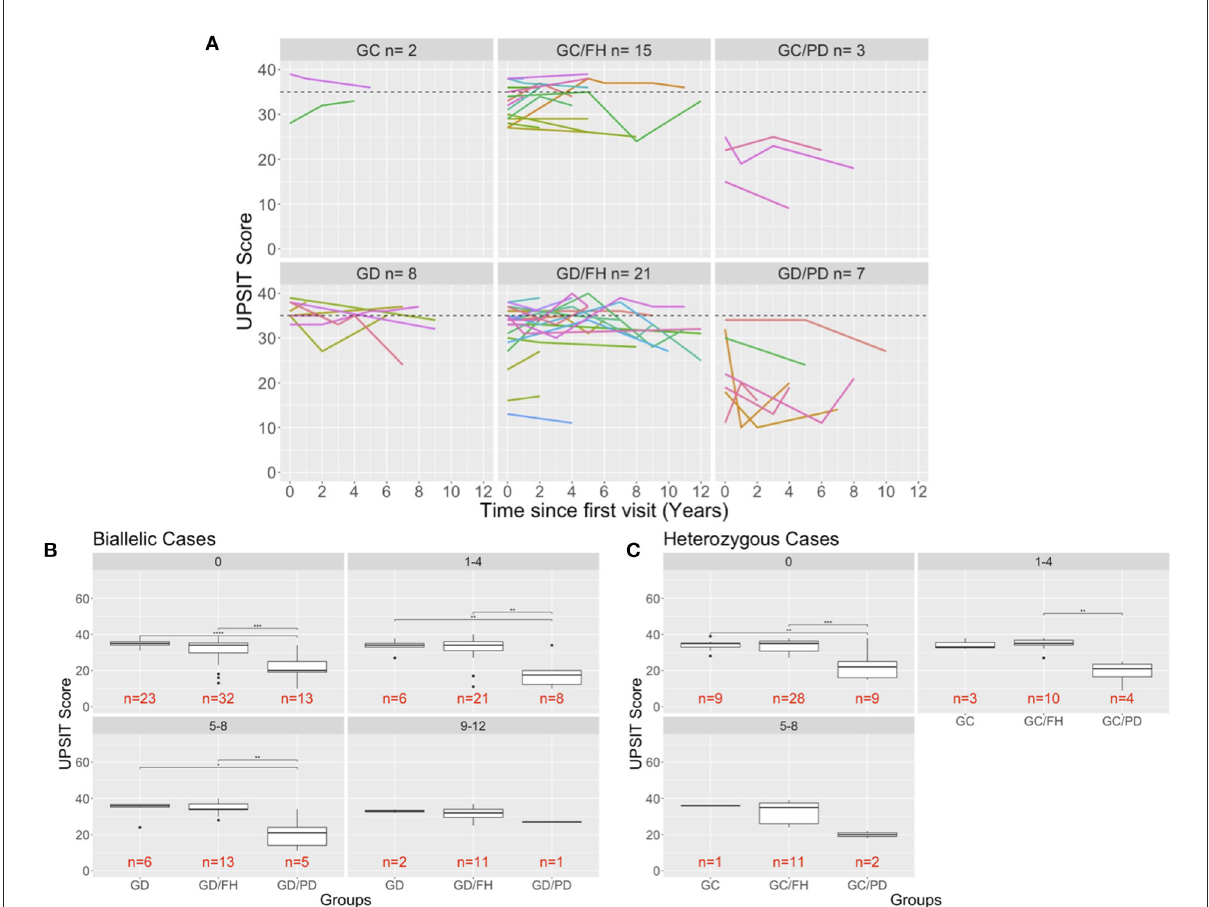
FIGURE2 Longitudinal evaluation of olfaction. (A) The UPSIT scores of individuals that were evaluated multiple time in the clinic are shown and each test date is shown in relation to the time of that has passed since the individuals first visit to the clinic. A dash line is drawn at 35 representing healthy UPSIT scores. (B,C) Comparison of biallelic (B) and heterozygous (C) groups across the different age ranges (0: baseline visit for a patient, 1–4: visits up to 4 years after the baseline visit). Significance is determined using Wilcoxon rank sum test ( p -values: ** < 0.01; *** < 0.001; **** < 0.0001). The 9–12-year age for the heterozygous groups was removed because only carriers with a family history of PD were measured that far out from the first